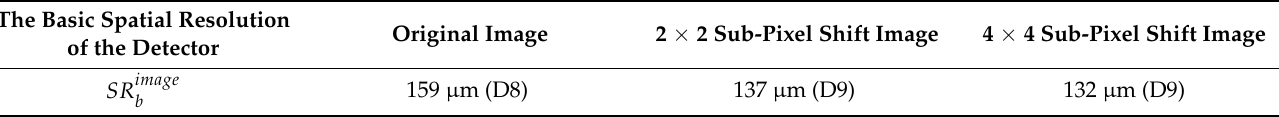
Table 8. Test results of the image spatial resolution SR image Table 8 Test results of the image spatial resolution 𝑆𝑅